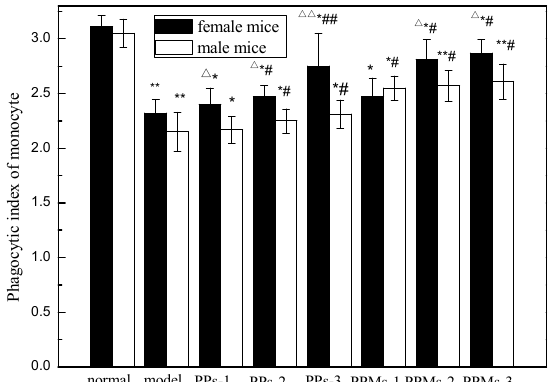
Figure 10. Effect of PP and PPM on phagocytosis of monocytes; the irradiation dose was 6 Gy. * p < 0.05 and ** p < 0.01 compared with the normal group; # p < 0.05 compared with the model group and ## p < 0.01 compared with the model group; Δ p < 0.05 compared with the male group in the same indicator and ΔΔ p < 0.01 compared with the male group in the same indicator (mean ± SD, n = 6).